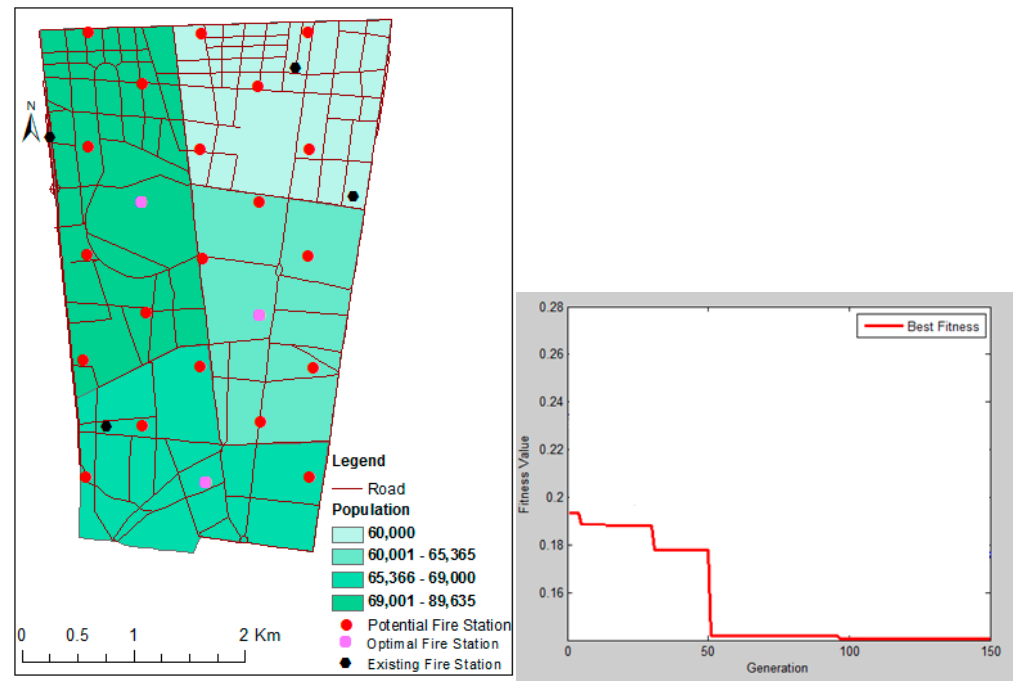
Figure 6. Optimal locations of fire stations, obtained from ordered capacitated multi-objective function with fixed weights ( W 1 = W 2 = W 3 = 0.3333 ) and output